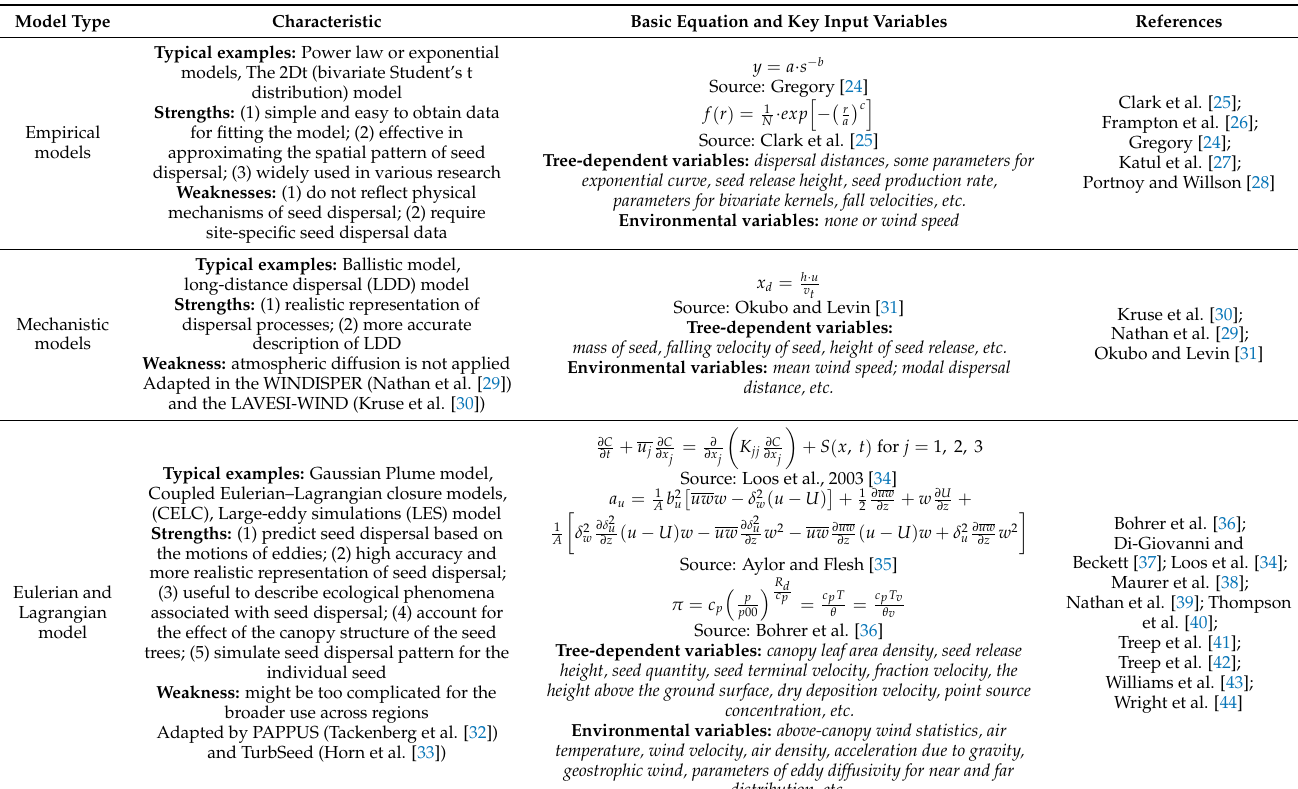
Table 1. A brief description of major seed dispersal